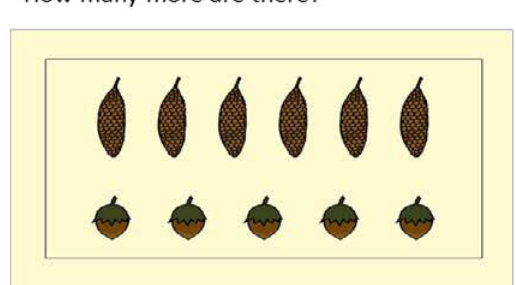
Figure 3: Relational number concept as difference between